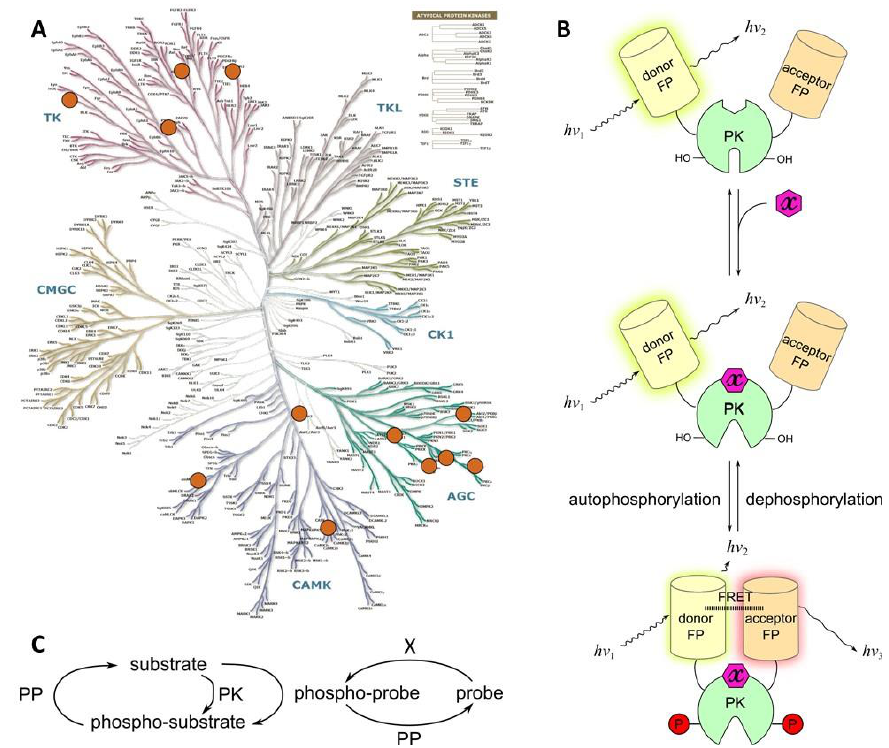
Figure 7. Class 4A probes: kinome coverage and principle of functioning. ( A ) Human PKs for which Class 4A probes (brown circles) have been reported (kinome tree adapted from [104], illustration generated by analog of software available at [105]). ( B ) Class 4A probes incorporate tagged PK, which performs autophosphorylation upon binding of an activating molecule (denoted as X). ( C ) Effect of Class 4A probes on phosphorylation of endogenous substrates (adapted from